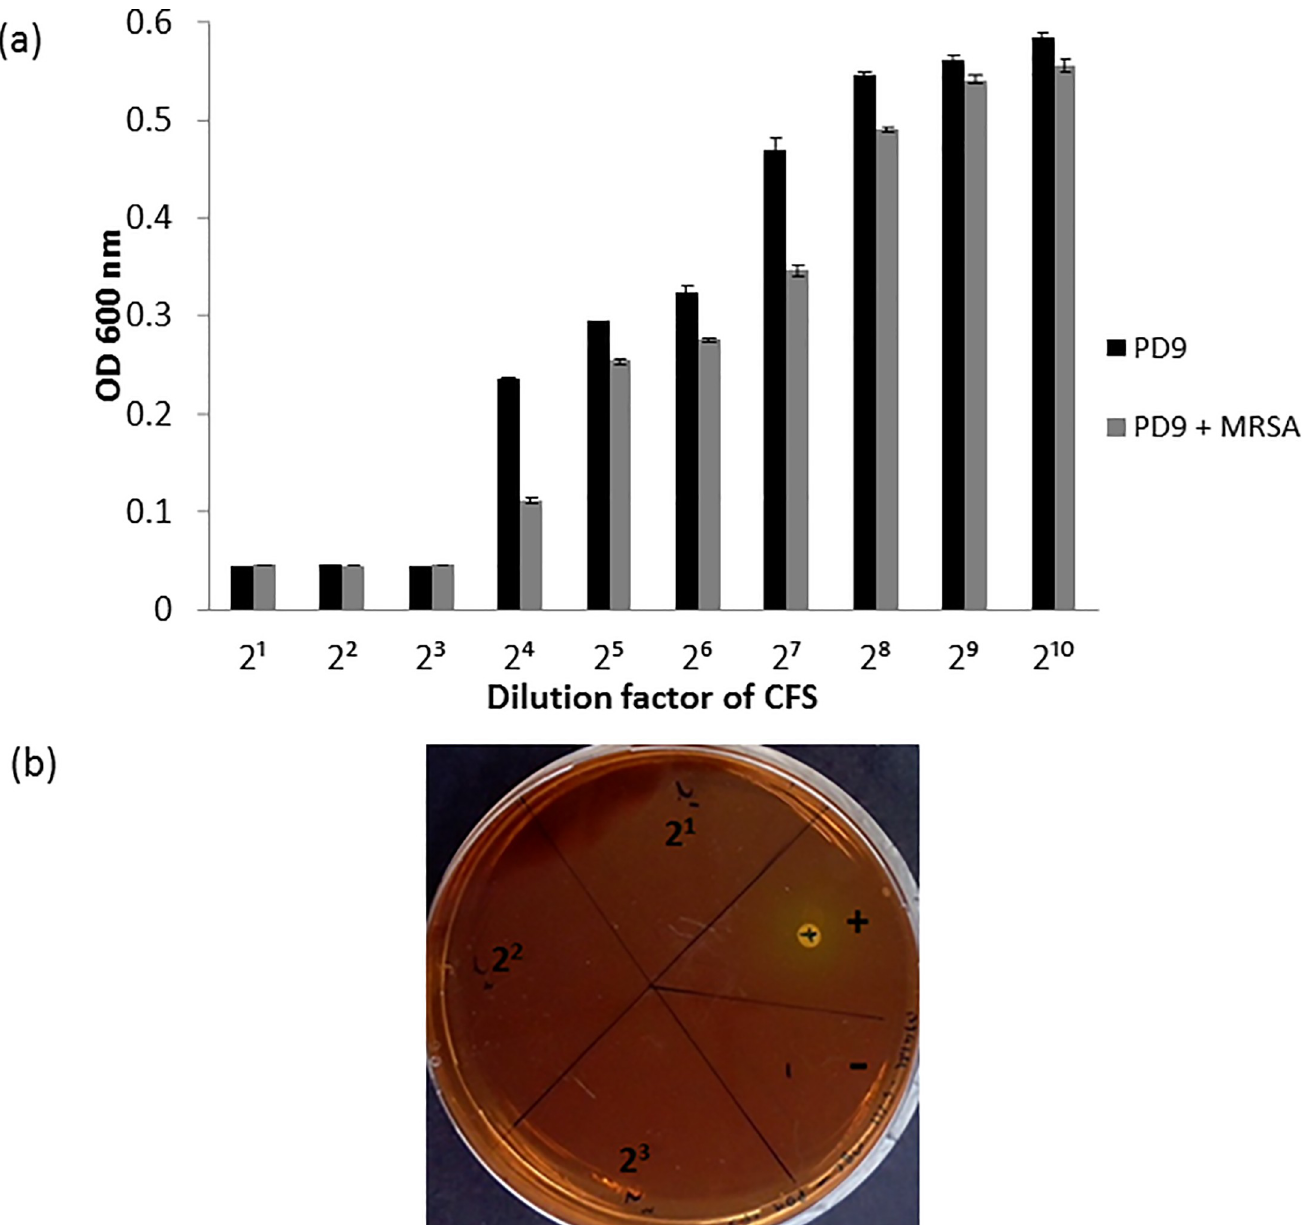
Fig 2. Determination of MIC and MBC values of B . velezensis strain PD9 CFS on MRSA ATCC 33742. (a) The determination of MIC value. Growth of MRSA ATCC 33742 in nutrient broth inoculated with different dilutions of CFS from (i) strain PD9 and (ii) strain PD9 + MRSA ATCC 33742, after 16 h incubation. Un- inoculated nutrient broth serves as negative control. Reported values are mean ± standard deviation (error bar). (b) The determination of MBC value. Bactericidal activity of strain PD9 CFS from dilution factors of 2 1 to 2 3 on MRSA ATCC 33742 observed on mannitol salt agar after 24 h incubation. MIC = minimum inhibitory concentration, MBC = minimum bactericidal concentration and CFS = cell-free